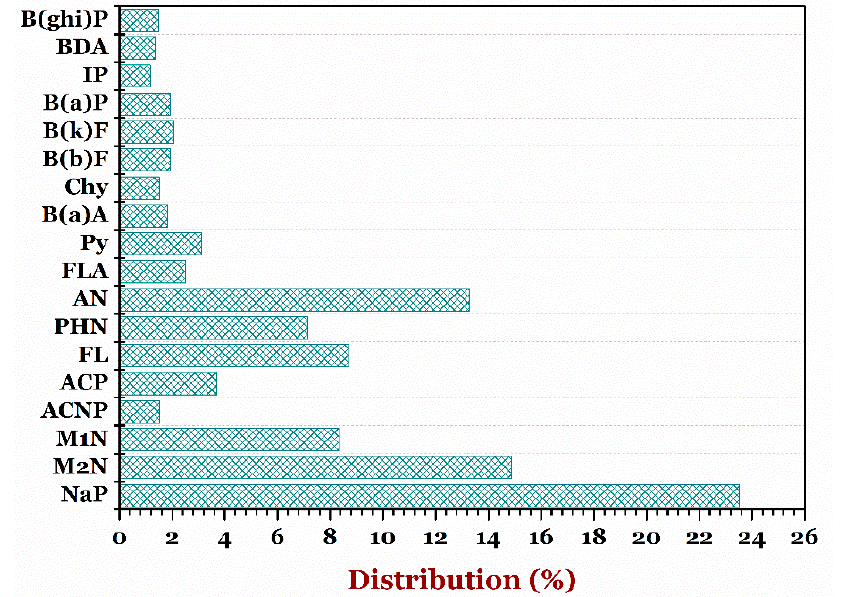
Figure 3. Distribution percentage of diffident kinds of polycyclic aromatic hydrocarbons in the